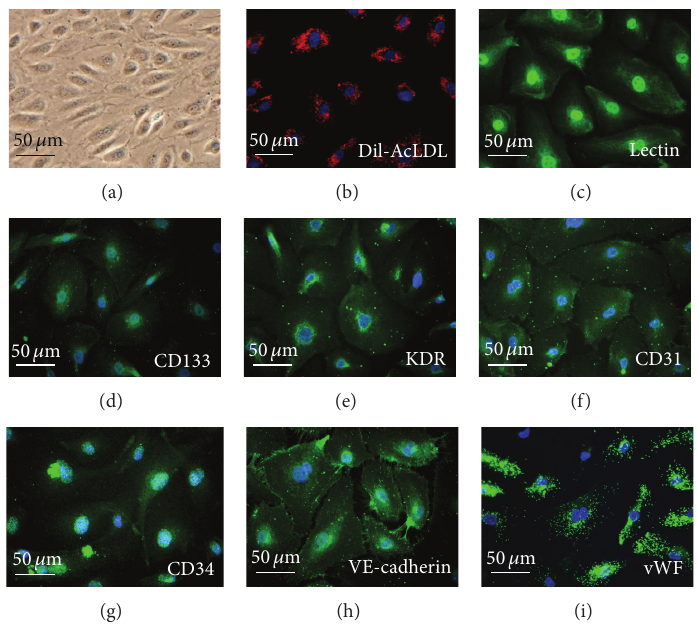
Figure 1: Morphology and characterization of EPCs from peripheral blood. (a) Peripheral blood mononuclear cells (MNCs) were plated on a fibronectin-coated culture dish on the fourteenth day. EPCs were also characterized by immunofluorescence staining for the expression of (b) DiI-AcLDL, (c) lectin, (d) CD133, (e) kinase insert domain receptor (KDR), (f) platelet/endothelial cell adhesion molecule-1 (CD31), (g) CD34, (h) VE-cadherin, and (i) Von Willebrand factor (vWF). Cells were counterstained with 4 󸀠 ,6-diamidino-2-phenylindole (DAPI) for the nuclei